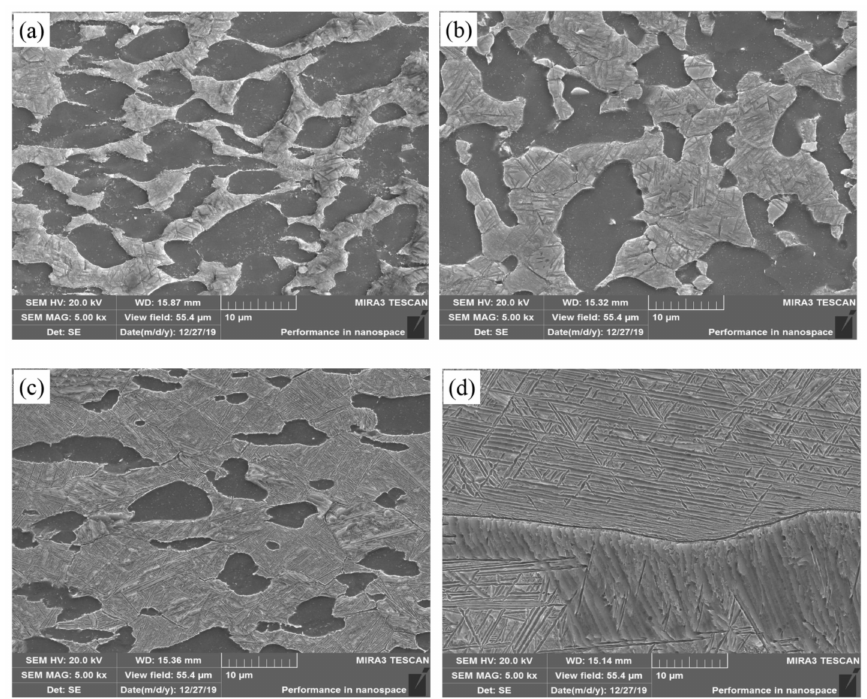
Figure 5. The SEM microstructure of Ti-6.5Al-3.5Mo-1.5Zr-0.3Si alloy after deformation at ( a ) 1123 K/0.1 s − 1 , ( b ) 1223 K/0.1 s − 1 , ( c ) 1223 K/10 s − 1 , and ( d ) 1323 K/0.1 s − 1